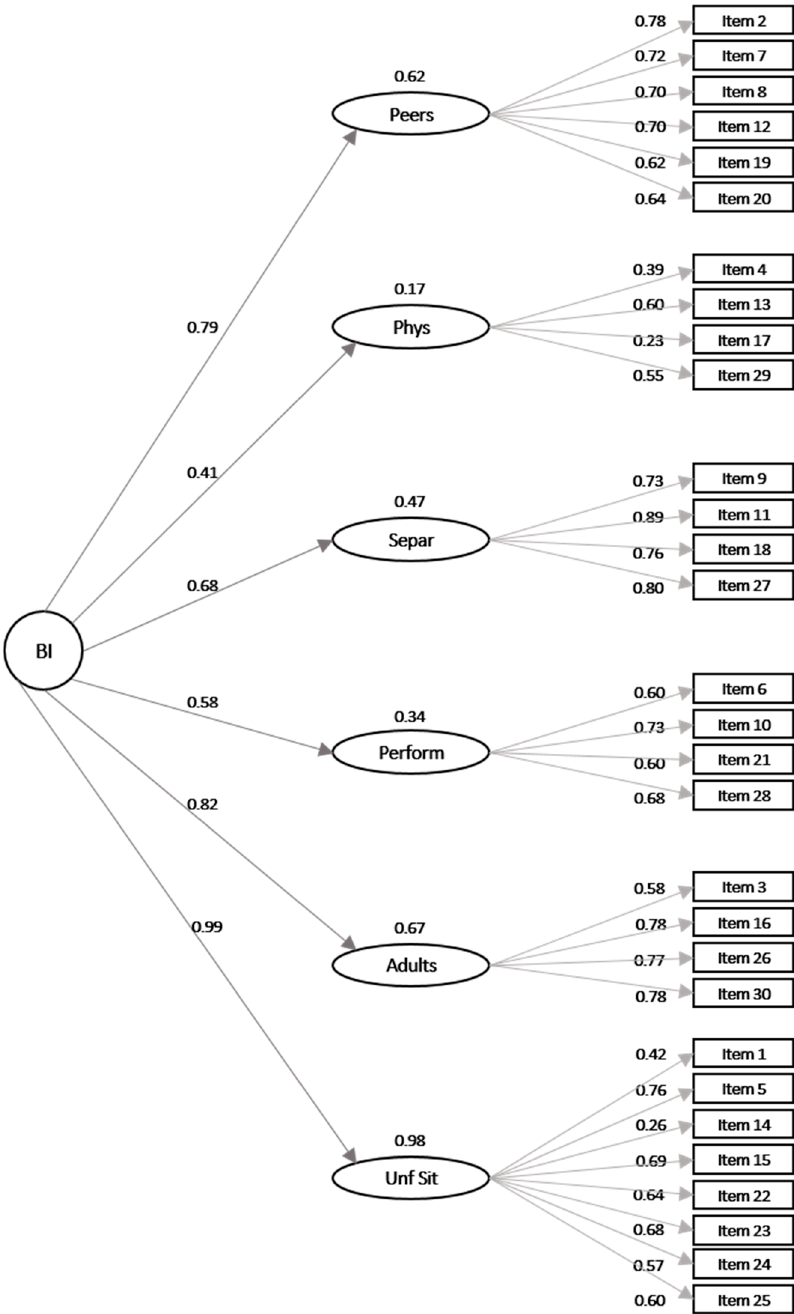
Figure 1. Representation of the standardized parameter estimate in Model 4. Note. BI = Behavioral Inhibition; Phys = Physical challenges; Separ = Separation; Perf = Performance situations; Unf Sit = Unfamiliar situations.